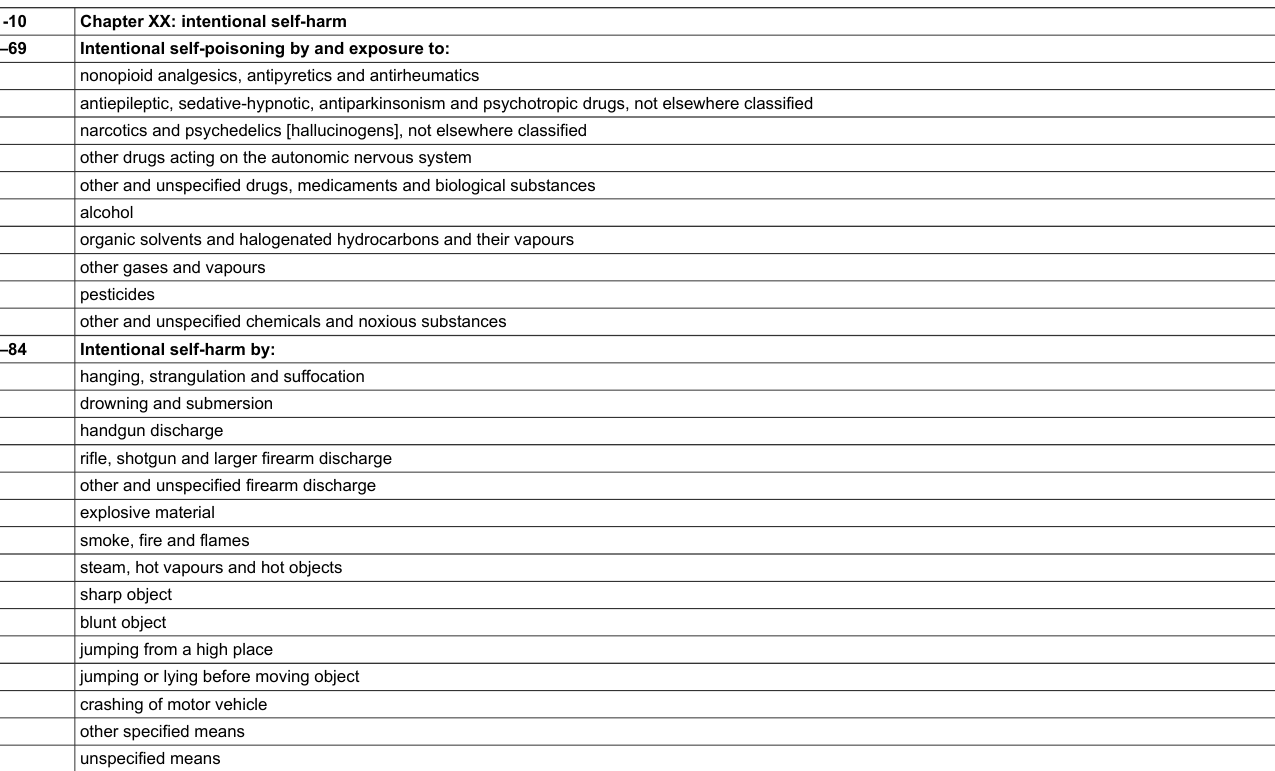
Table S1: ICD-10 codes for intentional